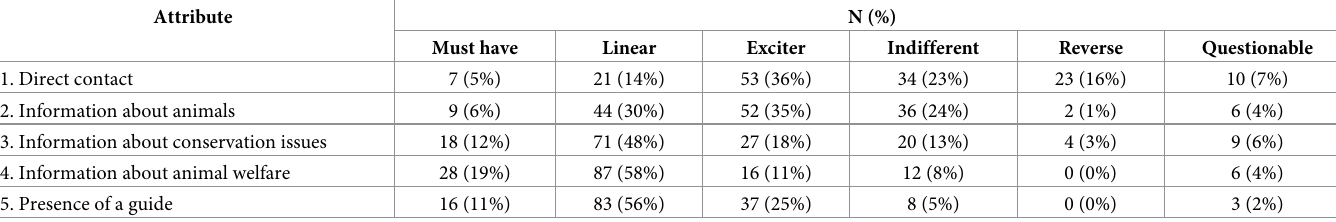
Table 5. Attributes investigated with the Kano Model and their distribution within the categories.